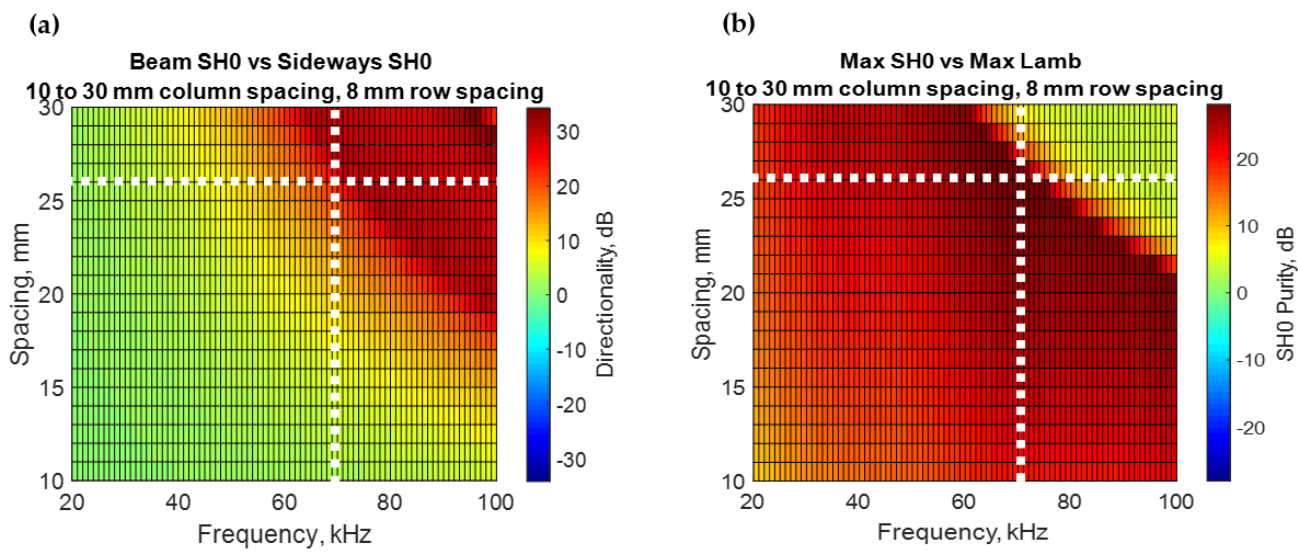
Figure 7. LSA results for 12 × 2 configuration shear transducer array: ( a ) SH 0 directionality and ( b ) SH 0 mode purity.